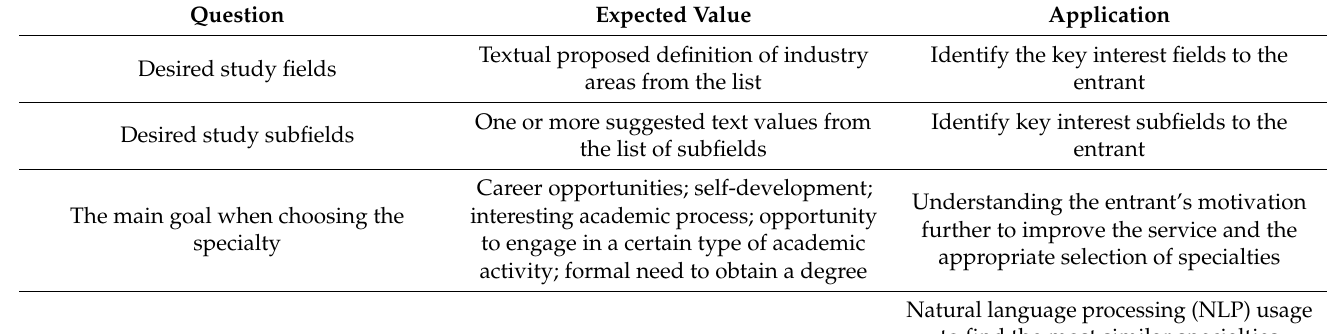
Table 2. Entrants respond to dataset structure for providing university specialty